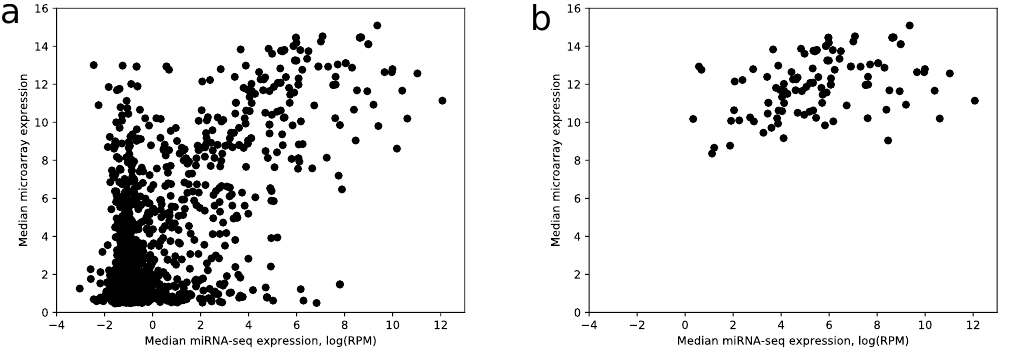
Figure 5. Median miRNA-seq expression vs. median microarray expression. ( a ) scatter plot showing joint distribution of median expression values for all miRNAs from microarray and miRNA-seq data; ( b ) same plot with miRNAs filtered by a 0.75 score value threshold. The logarithm base 2 was